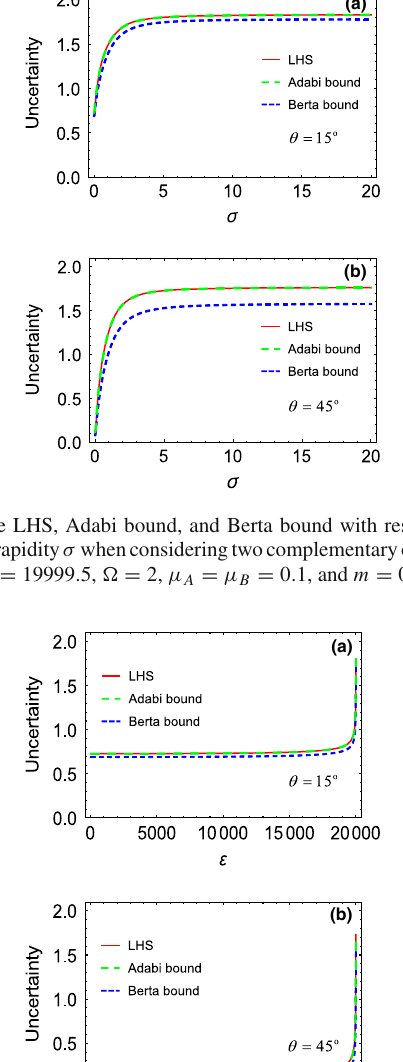
= μ = 0 . 1, and m = 0 . A B